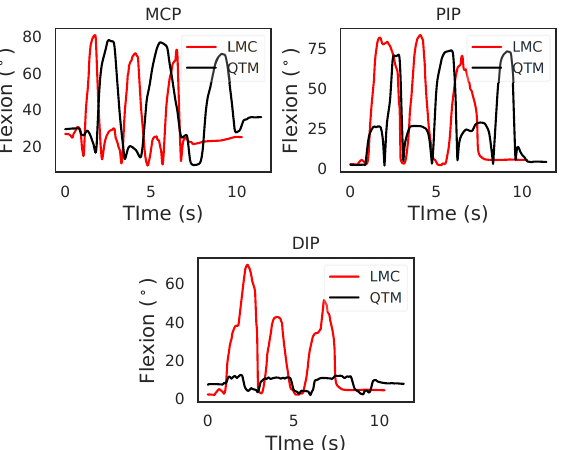
Figure 4. An example comparing the flexion trajectories of the LMC and QTM. This example is of index flexion motion, showing the flexion angles of the MCP, PIP and DIP